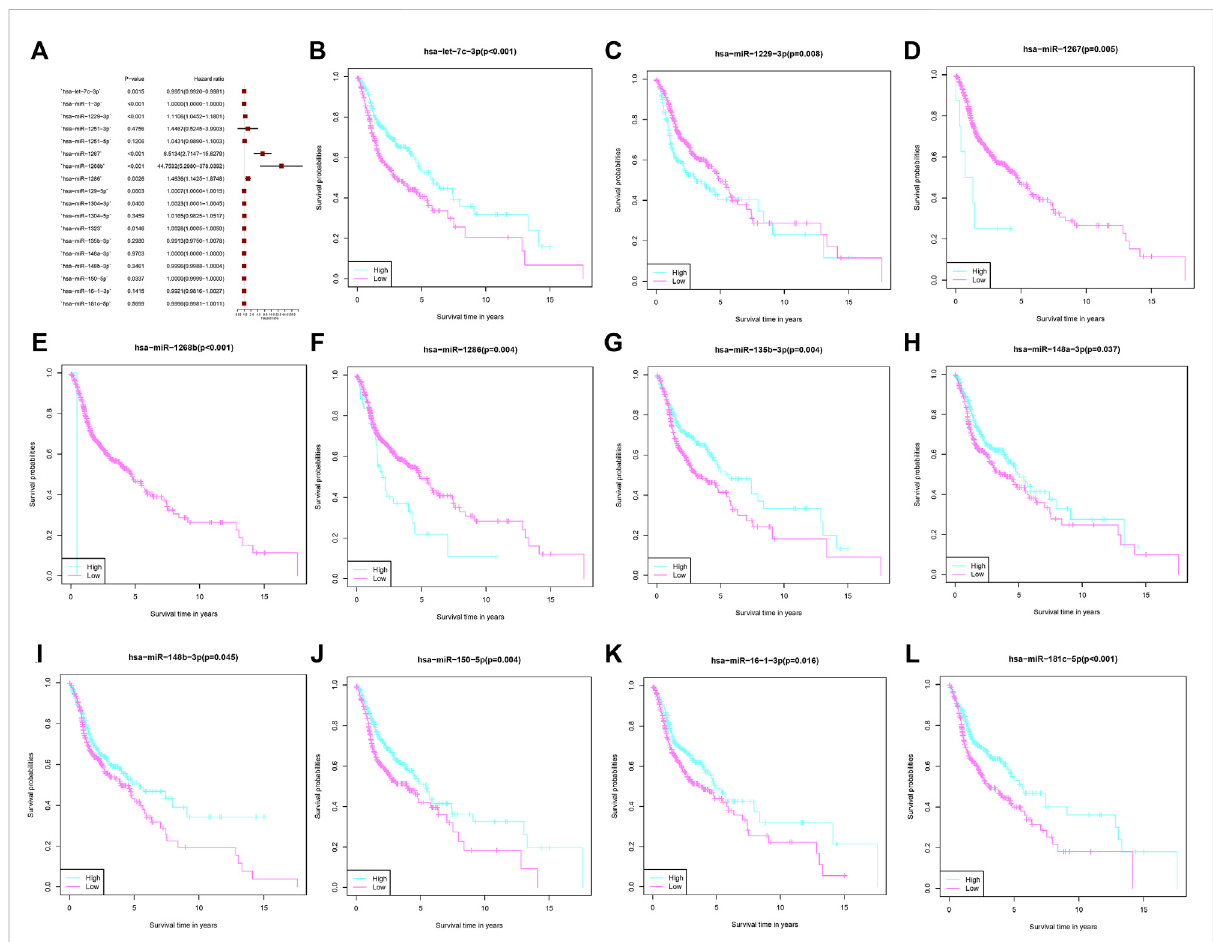
FIGURE 3 MicroRNAsassociatedwithfattyacidmetabolismthatcomprisetheriskscore. (A) MultivariateCoxregressionanalysisoffattyacidmetabolism- related microRNAs. (B – L) The overall survival comparison between the high- and low-risk score subgroups with regard to 11 fatty acid metabolism- related